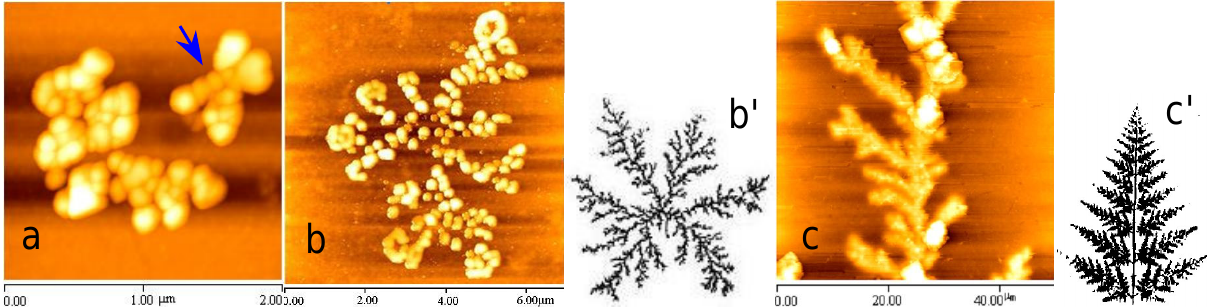
Figure 4. Colloidal particles (a) and fractal structure (b, c) of chitosan and their DLA models (b’, c’). The fractal dimension is 1.977 (b) and 1.960